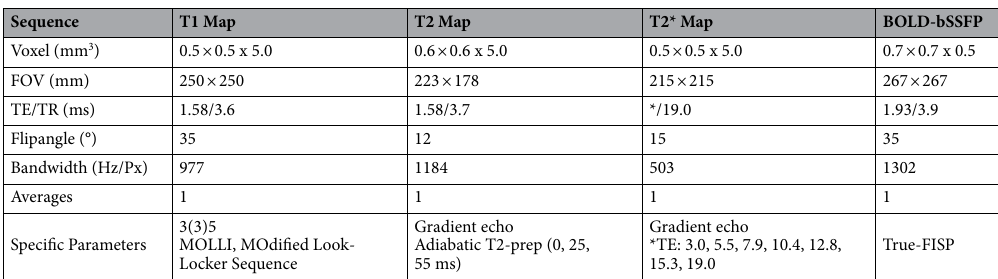
Table 1. Imaging parameters. FOV: Field of View, TE: Echo time, TR: Temporal Resolution.